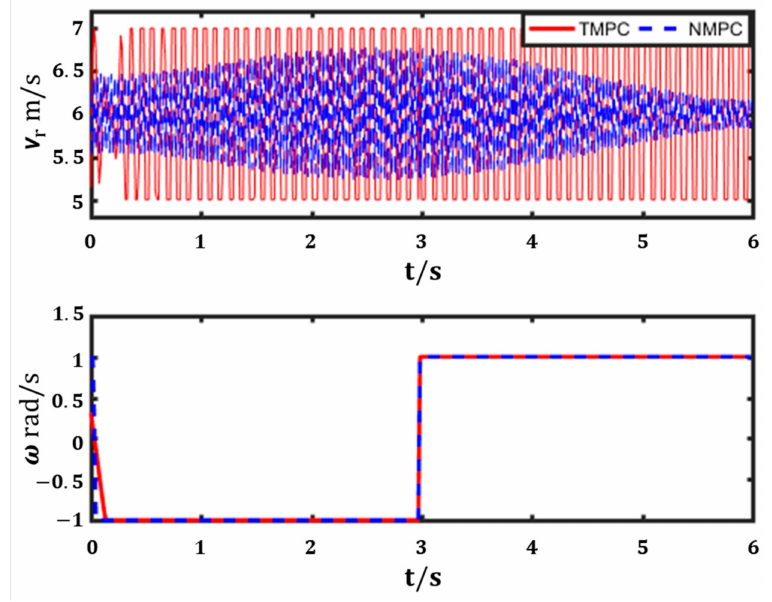
Figure 11. The control input of the TMPC and NMPC controllers under the